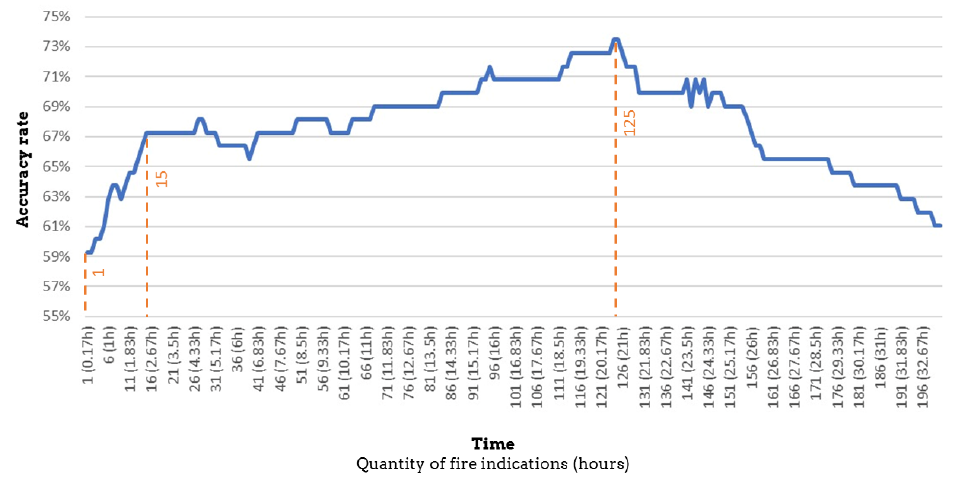
Figure 6. FM consecutive AF prediction assessment